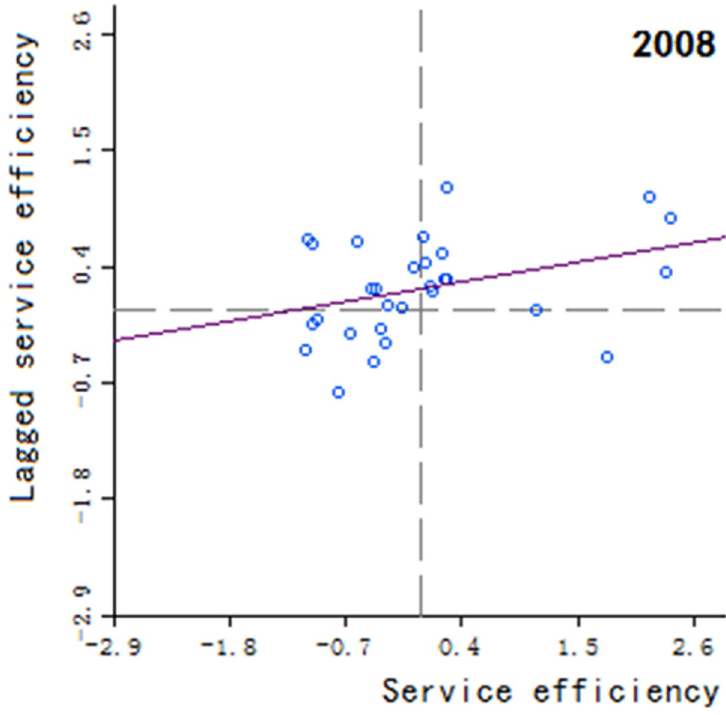
Fig 4. Scatter plot of China’s regional medical and health service level distribution from 2004 to 2018.